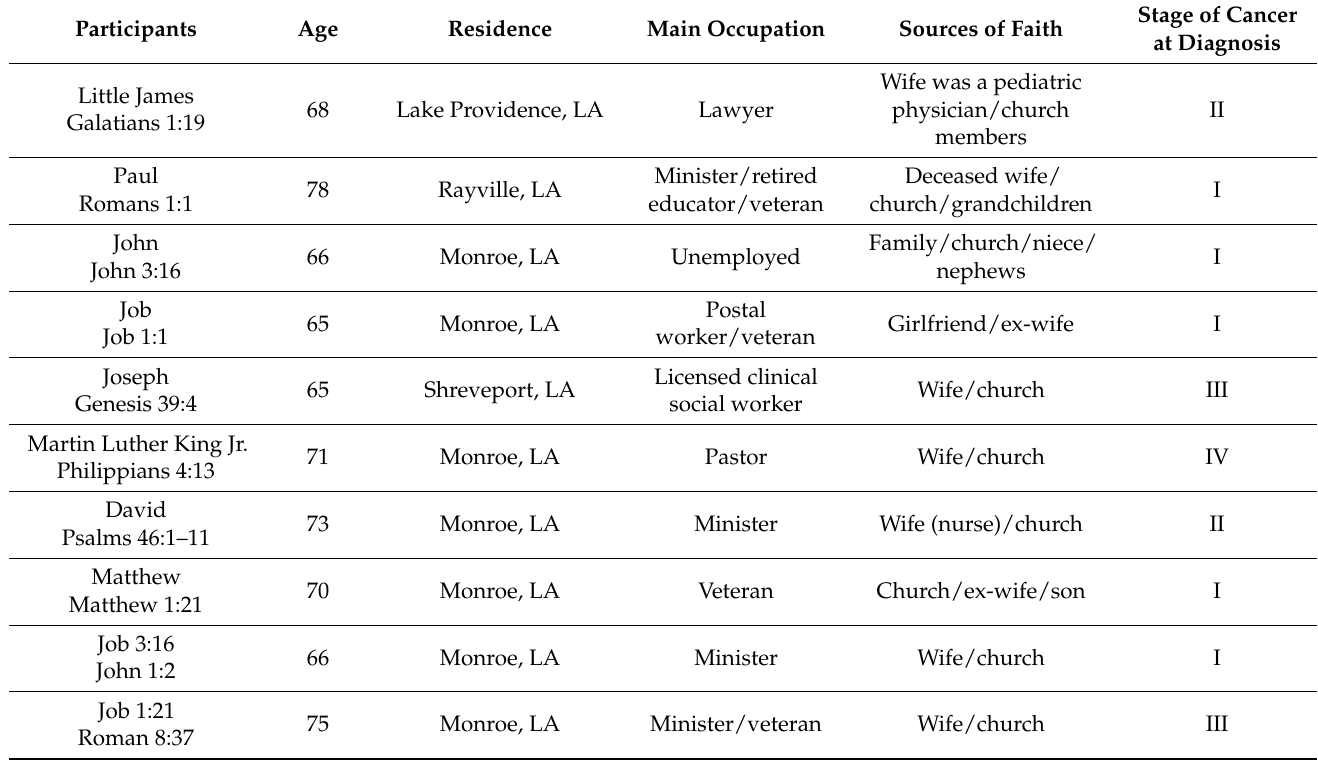
Table 1. Participant